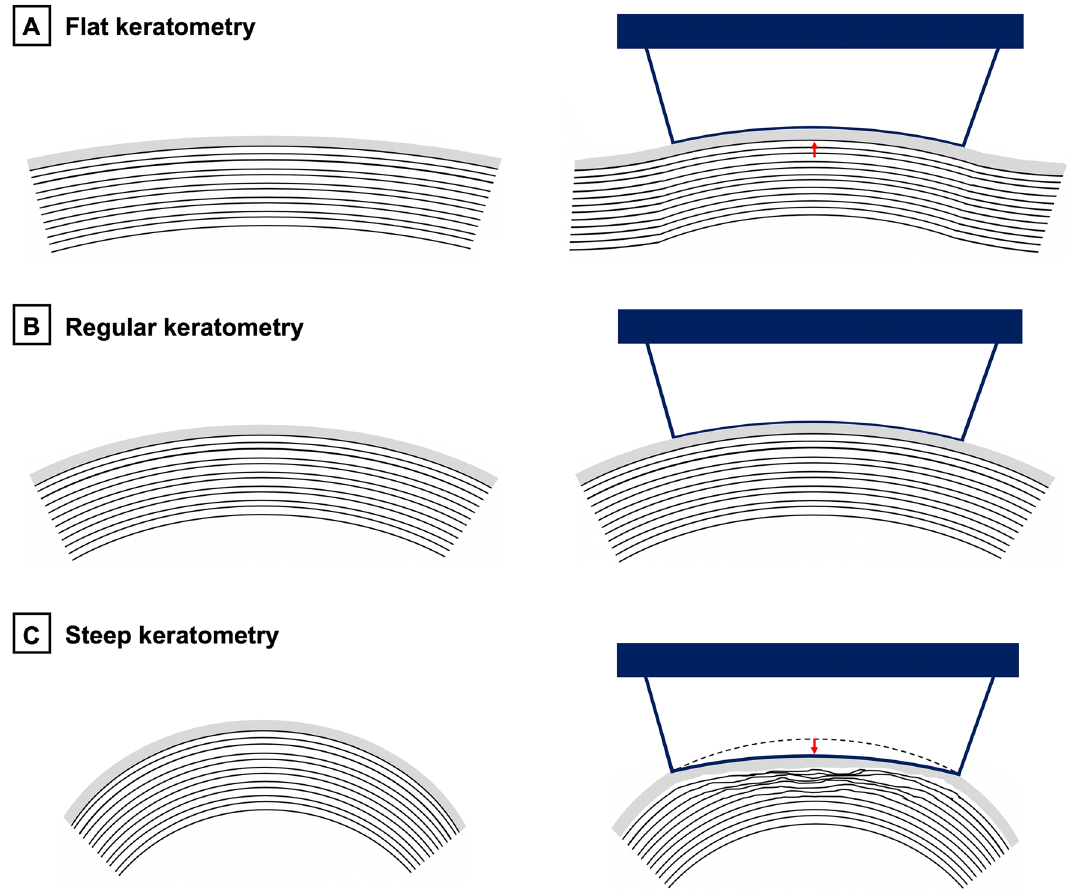
Figure 1. Tissue distortion due to a possible discrepancy between the radius of the femtosecond-laser contact glass and corneal curvature. In flat corneas ( A ), excess suction might deform the stroma by lifting the corneal surface into the contact glass. In steep corneas ( C ), central tissue compression might